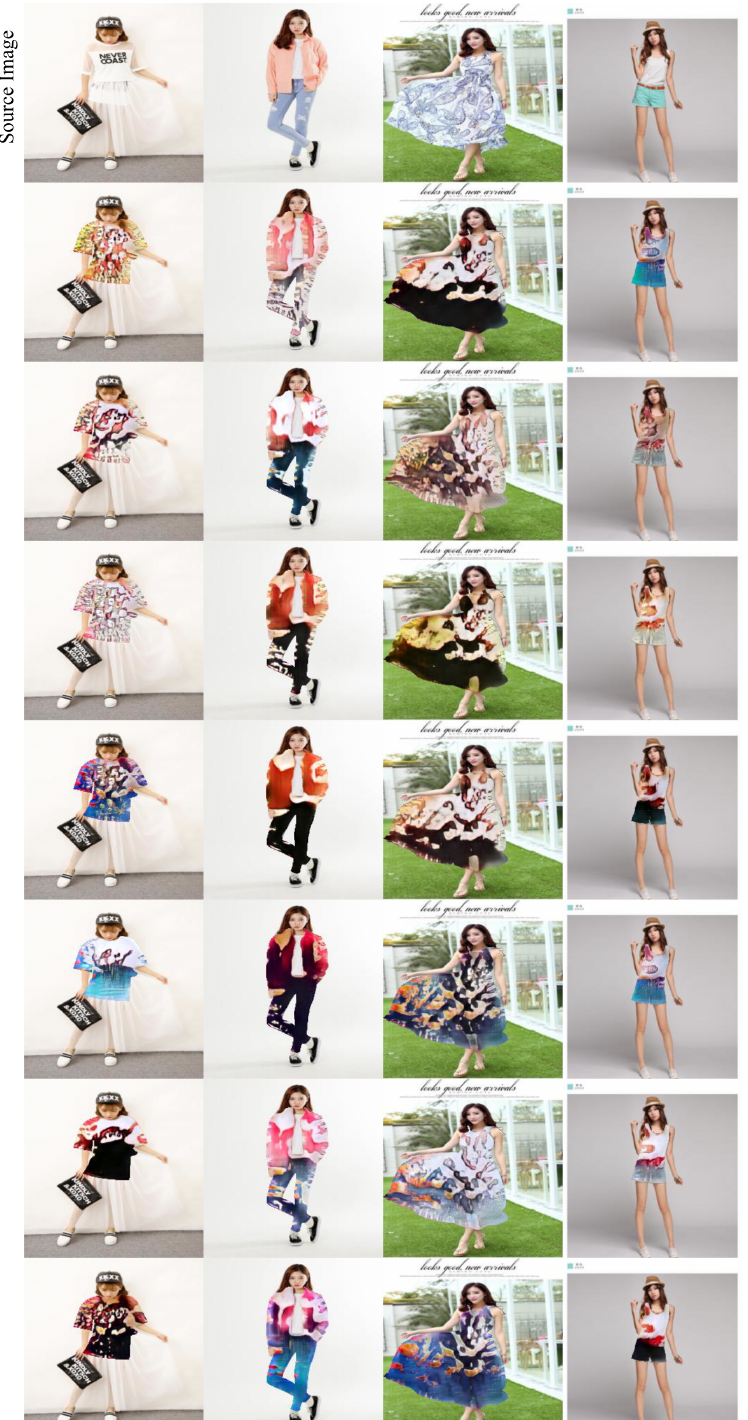
Figure 6. Different styles generated with the mapping network M